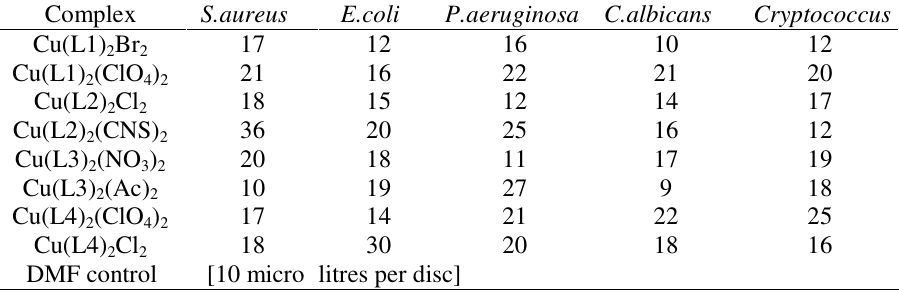
Table 3. Antimicrobial activity of Cu(II) complexes (Zone of inhibition in mm)